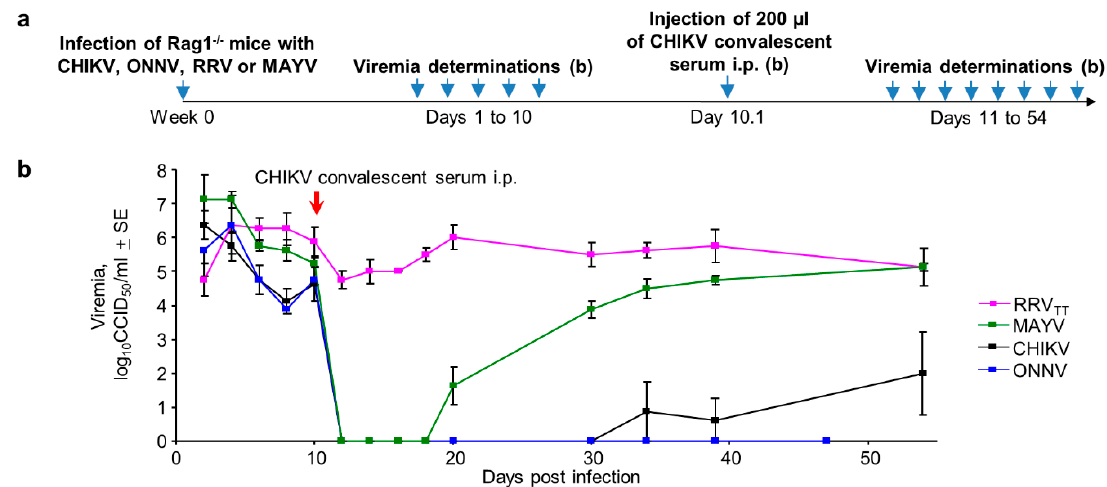
Figure 7. Antibody-mediated cross-protection in Rag -/- mice. ( a ) Timeline of infections, viremia determinations and injection of convalescent CHIKV mouse serum in Rag1 -/- mice; ( b ) Viremias for the indicated alphaviruses before and after injection of anti-CHIKV convalescent serum (n = 4 mice per group). (Limit of detection for each mouse 2 log 10 CCID 50 /mL.) For all reductions to undetectable viremia levels for each day relative to day 10, p = 0.037 by Kolmogorov–Smirnov tests (as differences in variance were infinite).